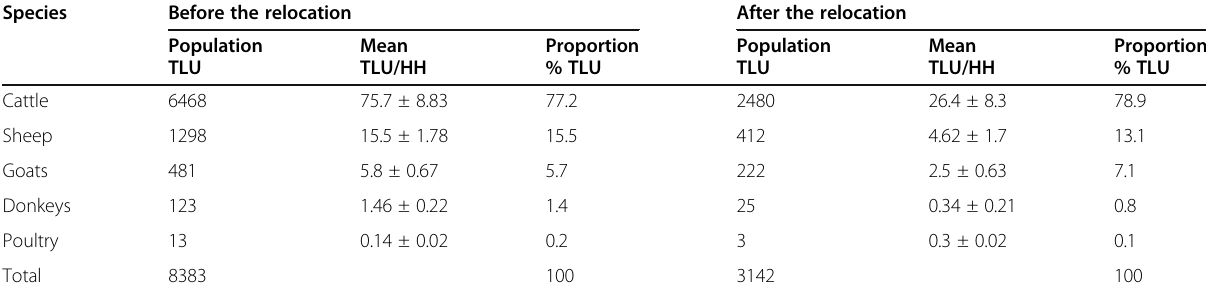
Table 2 Livestock species composition, populations, and mean household holding before and after the relocation Species Before the relocation After the relocation